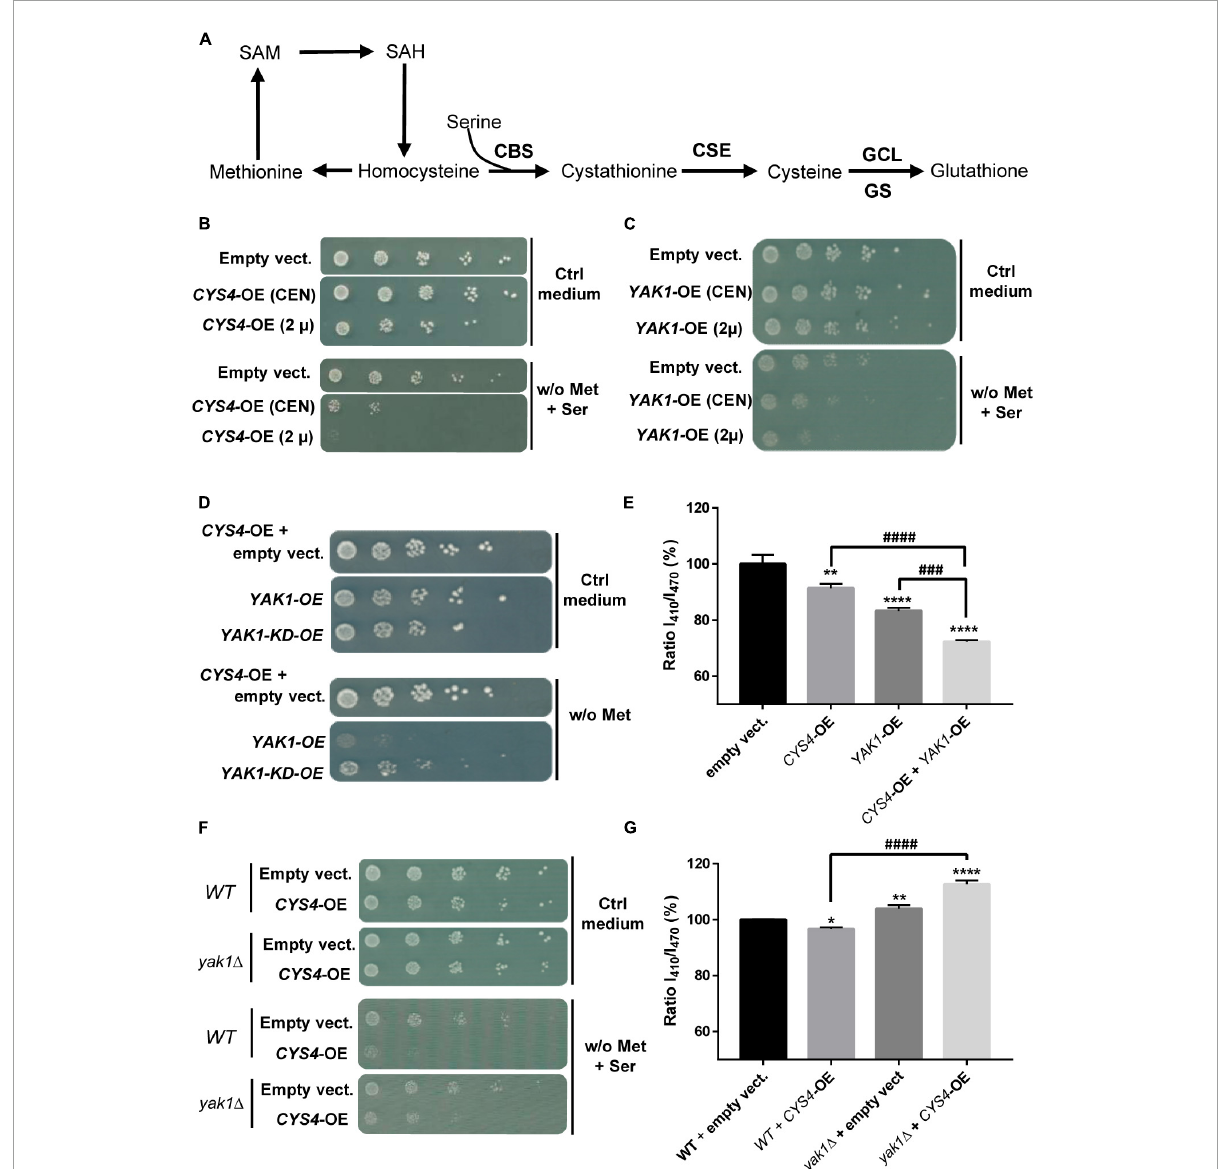
FIGURE1 Interaction between CYS4 and YAK1 . (A) Simplified representation of the transsulfuration pathway. Yeast CYS4 gene encodes the cystathionine beta synthase protein (CBS) which converts homocysteine and serine into cystathionine. The other enzymes of the transsulfuration pathway are CSE, GCL ( γ -glutamylcysteine synthetase), and GS (glutathione synthetase). CYS4/CBS overexpression would favor cysteine and glutathione synthesis at the expense of homocysteine and methionine. (B) Methionine auxotrophy of CYS4 -overexpressing ( CYS4 -OE) cells. Methionine auxotrophy, revealed by the absence of growth on medium lacking methionine, was assessed by spotting serial dilutions of wild-type yeast cells transformed with two centromeric ( CEN ) or 2 µ plasmids either empty or containing full length CYS4 , which expression in yeast is driven by the strong GPD promoter. The presence of a centromere segment ( CEN ) in plasmids enhances their mitotic stability but results in a lower copy number than 2 µ plasmids, thus producing less proteins. (C) Methionine auxotrophy of YAK1 -OE cells. Similarly to CYS4 -OE, YAK1 -OE leads to methionine auxotrophy using either a single centromeric plasmid ( CEN ) or a single 2 µ plasmid. (D,E) Additive effect of YAK1 -OE and CYS4 -OE. (D) YAK1 -OE (obtained with one single 2 µ plasmid) enhances methionine auxotrophy of CYS4 -OE cells (obtained with two 2 µ plasmids). This effect depends on the kinase activity of YAK1 as a kinase dead form of YAK1 ( YAK1 -KD) was not able to strengthen CYS4 -OE induced phenotype. Note that we used in these experiments a methionine-free medium without serine supplementation to be able to see stronger methionine auxotrophy than the one caused by CYS4 -OE. (E) YAK1 and CYS4 overexpression have additive effects on cytosolic acidification. (F,G) YAK1 deletion prevents CYS4 -OE induced phenotypes. (F) YAK1 deletion mitigates CYS4 -OE induced methionine auxotrophy. (G) Similarly, CYS4 -OE is not able to induce acidification defects in cells deleted for YAK1 suggesting that Yak1p is necessary for Cys4p activity. Note that YAK1 deletion even increases cytosolic pH, suggesting a decrease in GSH synthesis and/or the presence of oxidative stress which may deplete intracellular glutathione. (E,G) One-way ANOVA with Tukey’s post-hoc test. Comparison with DMSO: * p < 0.05; ** p < 0.01; *** p < 0.001; **** p < 0.0001. Comparison between conditions: ### p < 0.001; #### p <